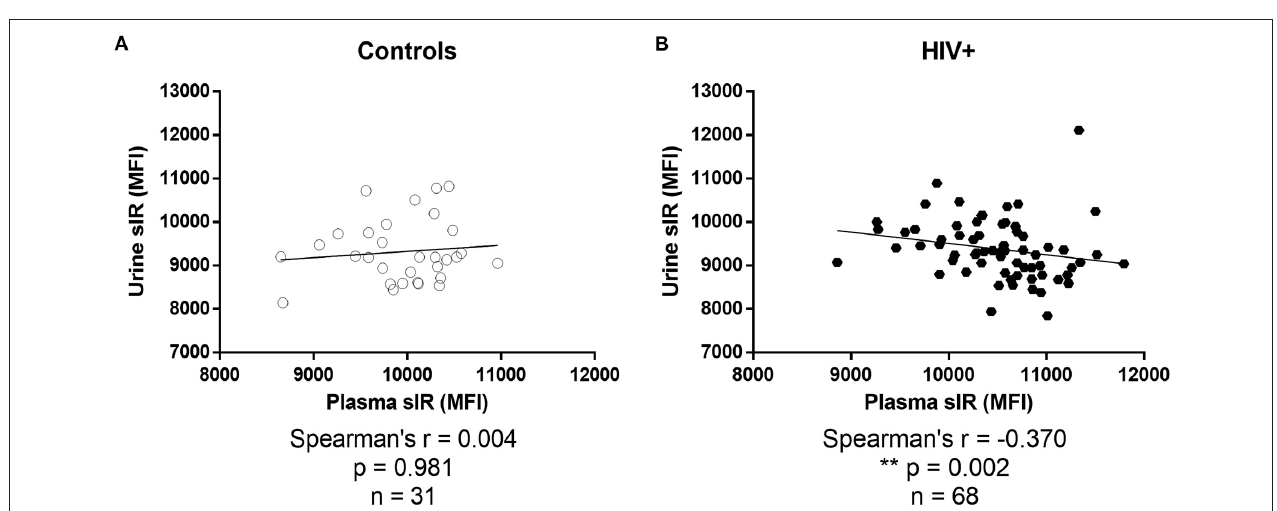
FIGURE 6 | Association between soluble insulin receptor levels in urine and plasma. Associations between sIR levels in plasma and urine were determined by Spearman’s correlations tests in controls (A) and HIV-infected women (B)